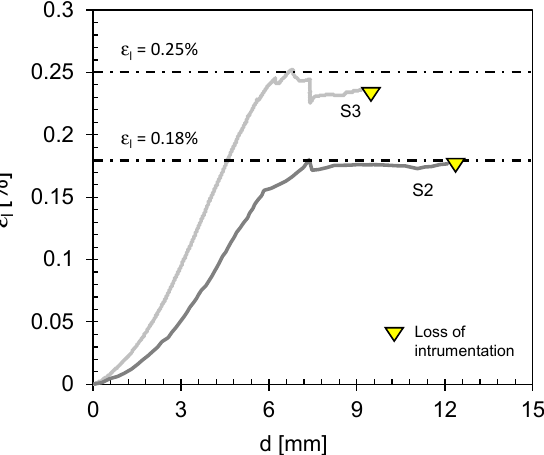
Figure 14. Longitudinal deformation vs. global displacement ( ε l -d) for the specimens S2 and S3 tested under the eccentric compressive load.